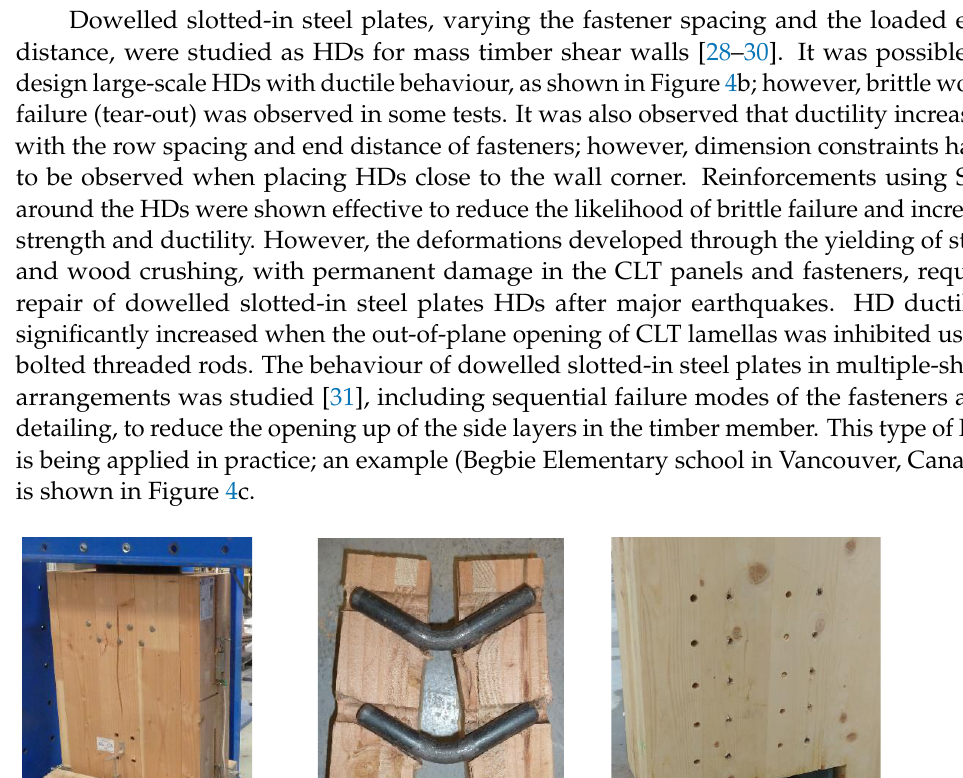
Figure 3. Nailed HDs: ( a ) brittle wood failure; ( b ) nail yielding; ( c ) steel bracket yielding (photo credit: ( a , b ) Cristiano Loss; ( c ) Thomas Tannert); ( d ) uplift force – displacement behaviour.